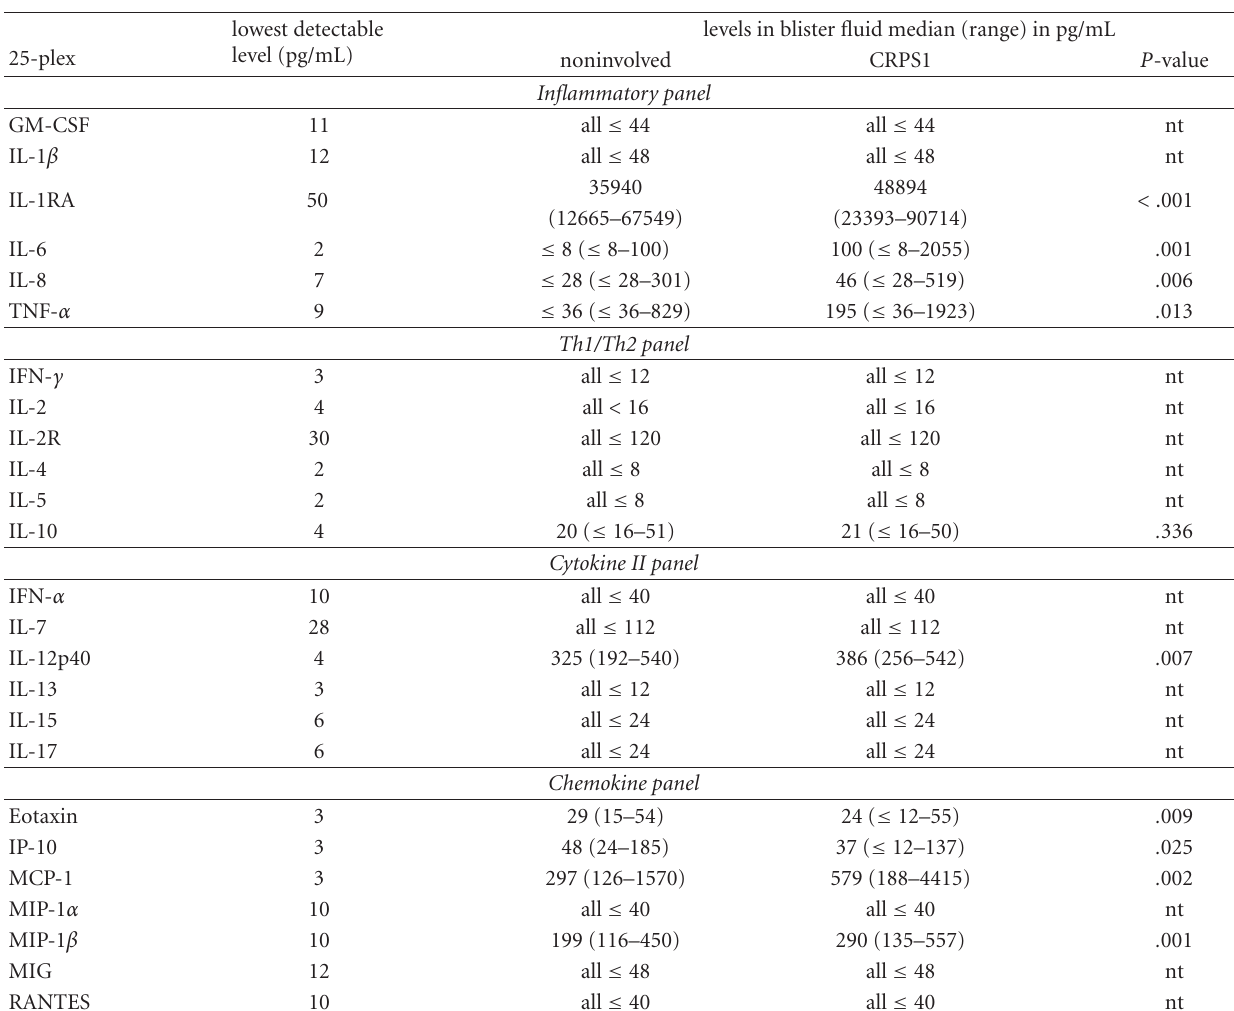
Table 3: Cytokine levels in blister fluids from 22 patients with complex regional pain syndrome measured by multiplex-25 bead array